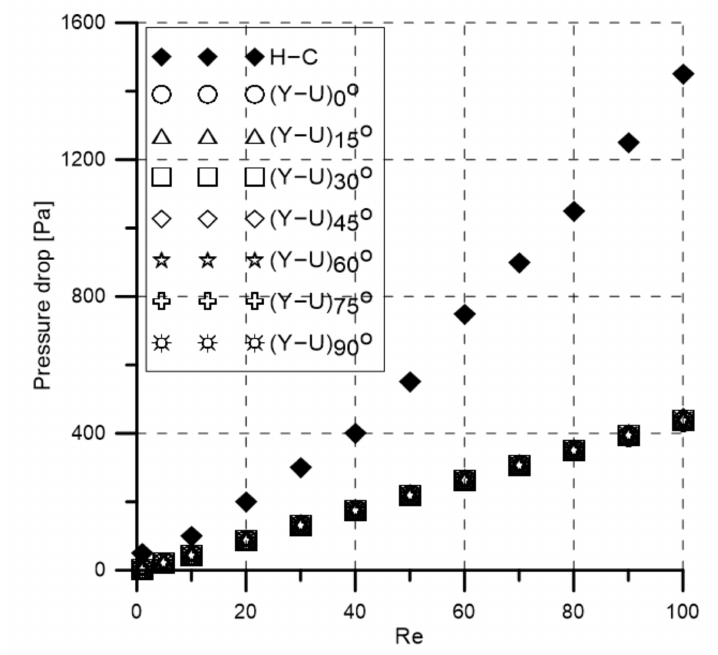
Figure 11. Pressure drop of the micromixers at various Reynolds numbers.